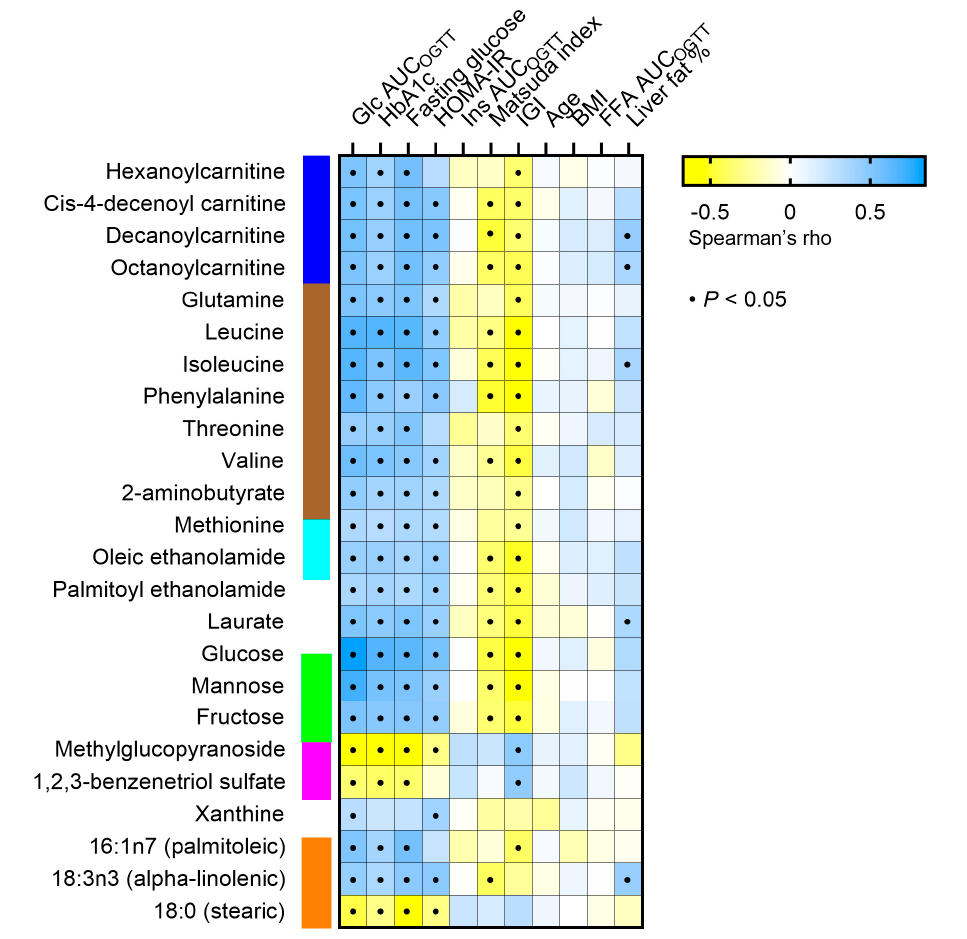
Figure 4. Correlation matrix between plasma concentration change of metabolites that significantly differ in response to the OGTT between controls and T2D individuals (rows) and several clinical parameters (columns). A black dot indicates a statistically significant correlation between the respective metabolite and parameter ( p < 0.05). Glc AUC OGTT : glucose area under the curve during the OGTT. HbA1c, glycosylated hemoglobin. Ins AUC OGTT : insulin area under the curve during the OGTT. IGI: insulinogenic index. FFA: free fatty acid. In blue, acylcarnitines; in brown, amino acids; in light blue, acyl ethanolamides; in green, monosaccharides; in magenta, xenobiotics; in orange, free fatty acids.